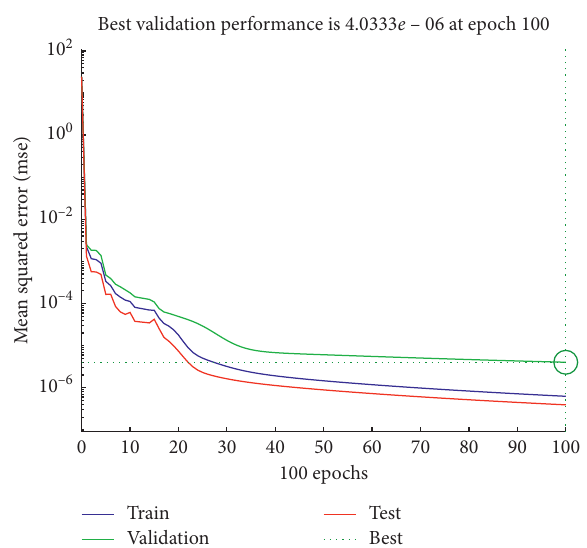
Figure 3: The error reduction graph under the early stop